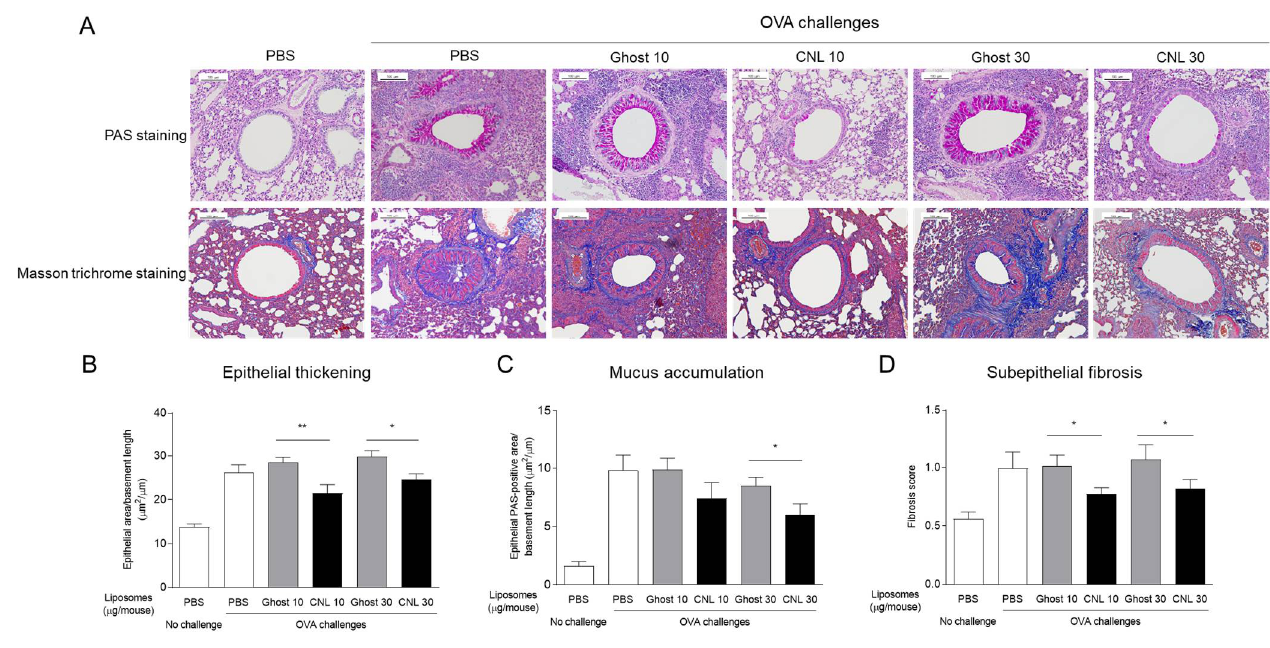
Figure 3. Effects of ceramide nanoliposomes (CNL) on airway remodeling. OVA-sensitized mice were challenged with OVA-free PBS or OVA. OVA-challenged asthmatic mice were treated with liposome-free PBS, ceramide-free Ghost or CNL. Lung tissues were subjected to histological analysis with PAS staining and Masson trichrome staining. Representative images of PAS and Masson trichrome staining are shown ( A ). In PAS staining, scores for epithelial thickening ( B ) and mucus accumulation ( C ) were determined. Fibrosis scores were quantified by Masson trichrome staining ( D ). Data are shown as mean ± S.E. ( n = 10–13). * p < 0.05, ** p < 0.01 compared to the Ghost group. Table 1. Effects of ceramide nanoliposomes (CNL) on the number of ILC2, Treg, and Tr1 cells in lung tissues. OVA-sensitized mice were challenged with OVA-free PBS or OVA. OVA-challenged asthmatic mice were treated with 30 μg/animal ceramide-free Ghost or CNL. Cell numbers of ILC2, Treg, and Tr1 cells isolated from lungs were determined. Data are shown as mean ± S.E.